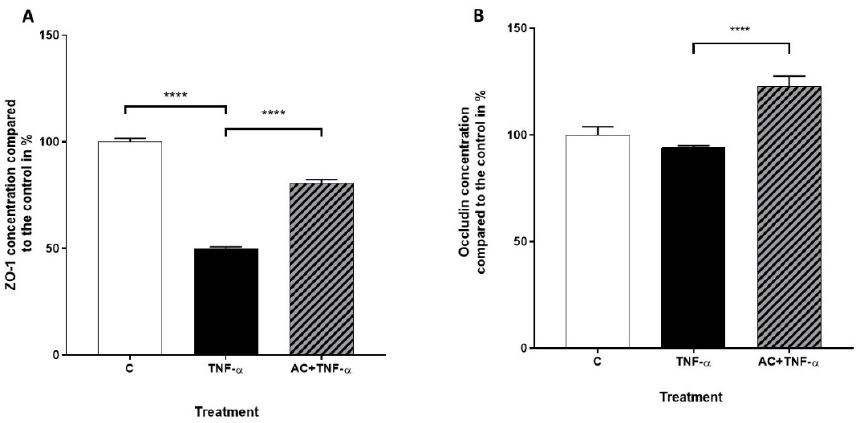
Figure 5. The effects of anthocyanin sour cherry extract on TNF- α induced ZO-1 and Occludin protein levels. Caco-2 were treated with TNF- α (50ng/mL) and 100 µ M AC + TNF- α (50ng/mL) for 24h. The protein levels of ZO-1 ( A ) and Occludin ( B ) were determined by Flow Cytometry and the means were normalized to un-treated control. Data are presented as mean ± SEMs. n = 3. The significance of differences between sets of data was calculated by ANOVA. **** p < 0.0001.